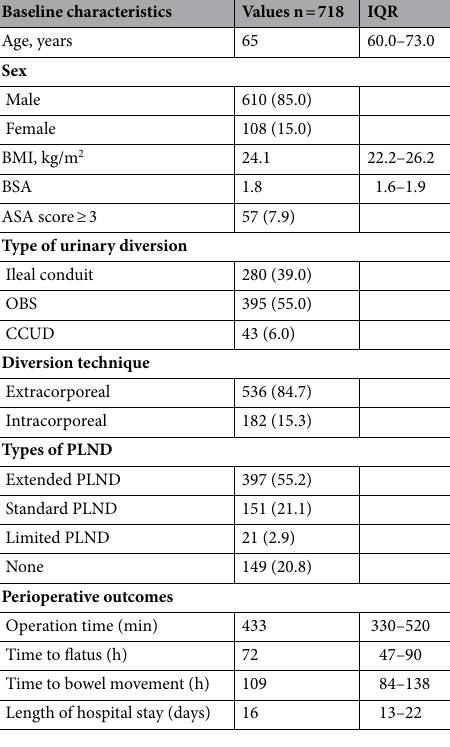
Table 1. Baseline characteristics of patients and perioperative parameters. Values are presented as number (%) or median. ASA American Society of Anesthesiologists, BMI body mass index, BSA body surface area, CCUD continent cutaneous urinary diversion, IQR interquartile range, OBS orthotopic bladder substitution, PLND pelvic lymph node